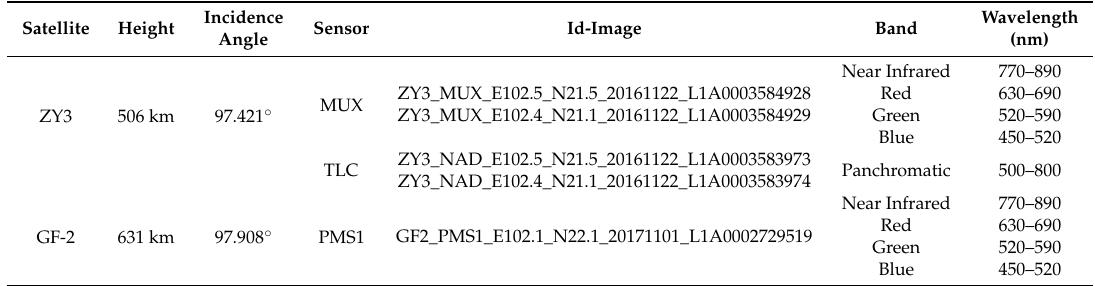
Table 2. Description of the satellite images. GF-2: GaoFen-2, ZY3: ZiYuan3.